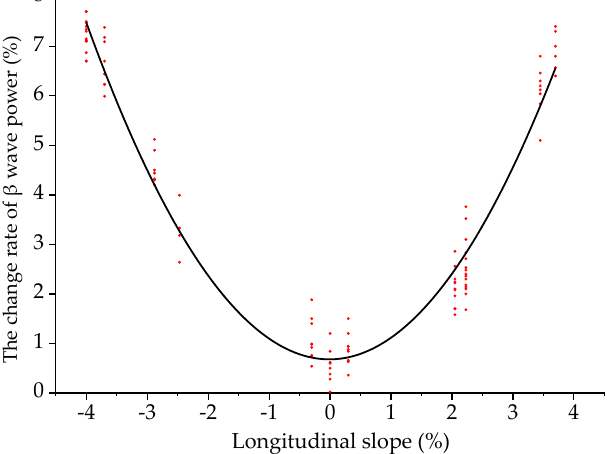
Figure 8. Fitting curve of the longitudinal slope and P β .